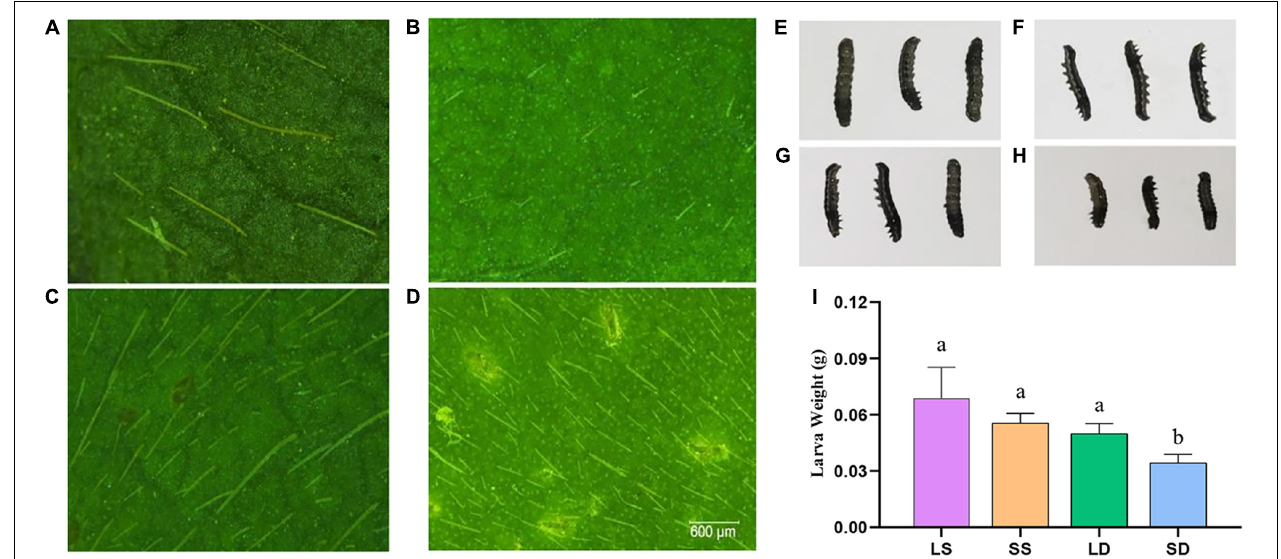
FIGURE 5 | The resistance to CCW of lines with different pubescence length and density. (A–D) Typical photographs of four different pubescence morphology. (A) Long and sparse (LS); (B) short and sparse (SS); (C) long and dense (LD); (D) short and dense (SD). CCW, common cutworm. (E–H) Larvae morphology after feeding with leaves of four different pubescence morphology. ( E–H corresponds to A–D , respectively). (I) The added larval weight was inoculated with the leaves of four different pubescence morphology. Significant differences were shown by different letters ( P ≤